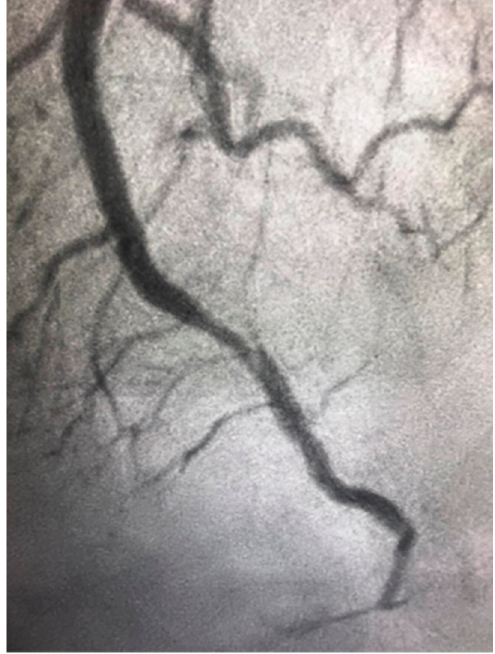
Figure 4. Spontaneous coronary artery dissection in the distal left anterior descending artery in a 46-year-old woman presenting with ST elevation myocardial infarction.